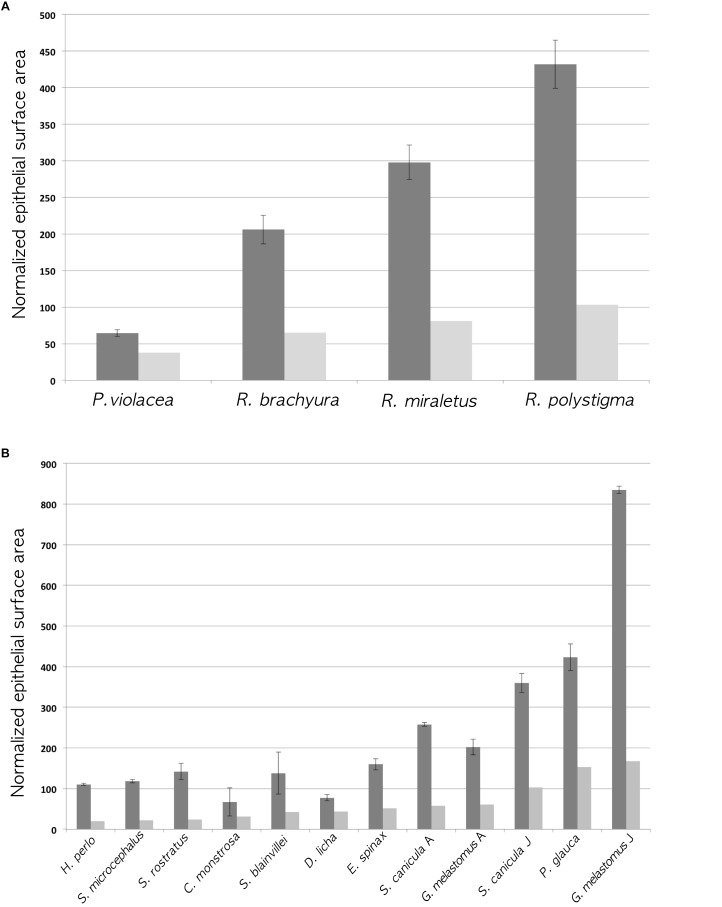
Histograms of the normalized gross surface area (light gray; see Table 2 ninth column for values) and the normalized surface area with secondary folds (dark gray; see Table 2 eleventh column for values). The error bars of the latter are calculated using the standard deviation of the percentage of increase of the surface (see Table 2 twelfth column for the standard deviations). (A) Batoidea specimens. The surface area (mm2) multiplied by 100, was normalized dividing for the square disk width (cm2). (B) Non-batoidea specimens. The surface area (mm2) multiplied by 100, was normalized dividing for the square total length (cm2).